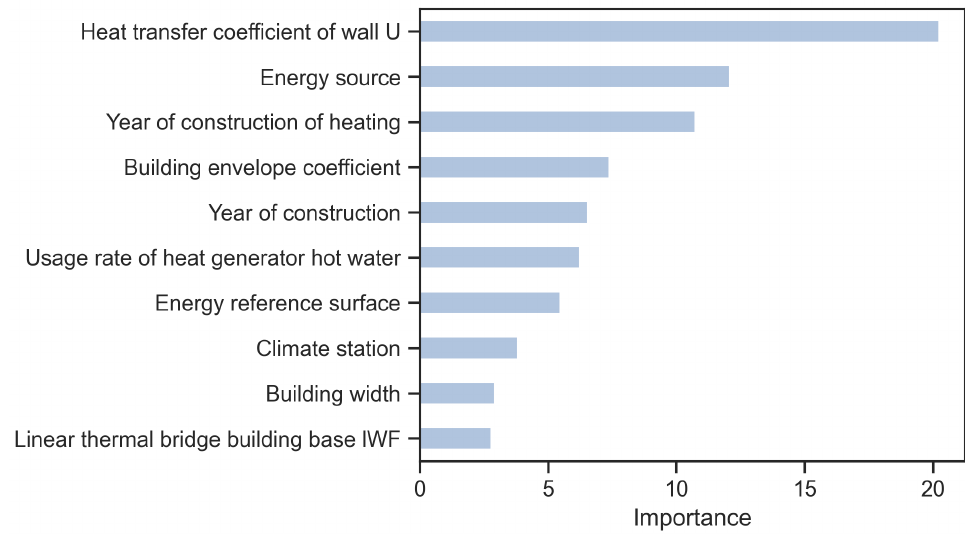
Figure 5. Feature importance of the first ten variables used by